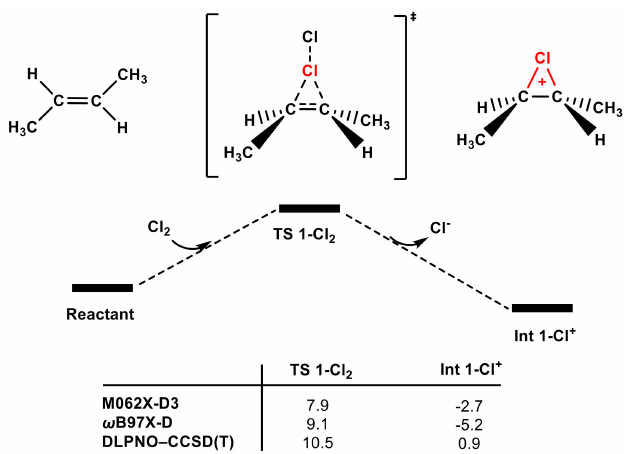
Figure 6. The partial PES of the reaction of Cl 2 attacking trans-1,2-dimethylethylene (see SI for the whole PES). The Gibbs free energies of TS 1-Cl 2 and Int 1-Cl + obtained using different methods are included (in kcal mol − 1